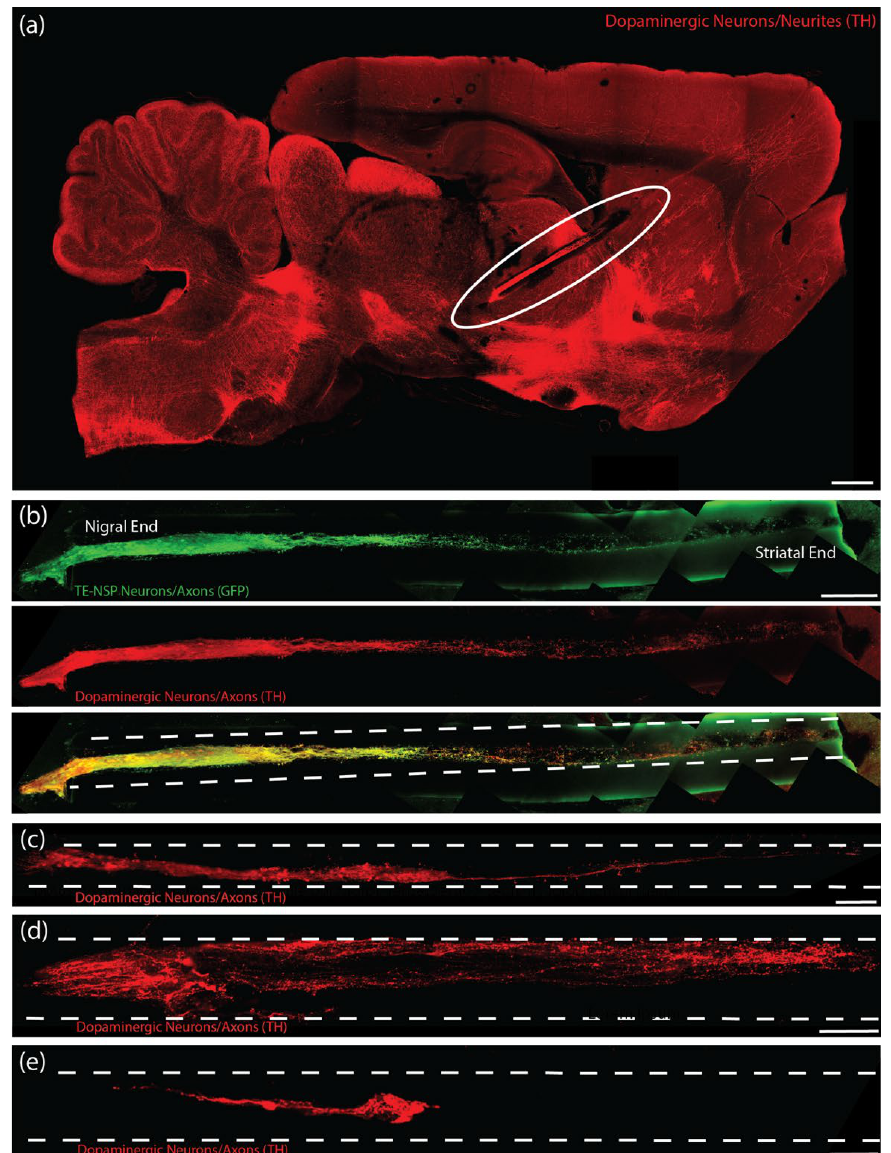
Figure 9. TE-NSP neuronal survival and axon architecture at 1-month post-implant in rat 6-OHDA lesion model of PD. ( a ) Representative confocal reconstruction of an enriched TE-NSP 1-month post- implant labeled via immunocytochemistry to denote dopaminergic neurons/axons (TH, red). The aggregate end of the TE-NSP was positioned in the SN while the axonal end of the TE-NSP ter- minated in the striatum. Implanted neurons and axons tracts were preserved in lesioned animals. Background has been increased to display the intact physical structure of the brain surrounding the implant and along its implantation path. ( b ) Representative confocal reconstruction of an enriched TE-NSP 1-month post-implant labeled via immunohistochemistry to denote GFP (GFP, green) and dopaminergic neurons/axons (TH, red). ( c – e ) Representative confocal reconstructions showing various types of implanted constructs at 1-month post-implant labeled via immunohistochemistry to denote dopaminergic neurons/axons (TH, red). ( c ) Enriched TE-NSPs maintained their cytoarchi- tecture with discrete somata and axonal regions; they also demonstrated neurites spanning the full length of the micro-column. ( d ) Non-enriched TE-NSPs generally did not exhibit neurites spanning the length of the micro-column. ( e ) Enriched aggregates added to micro-columns 1 day prior to implant did not display long-distance neurite outgrowth within the micro-column. Scale bar ( a ) = 1 mm. Scale bar ( b ) = 250 µ m. Scale bar ( c ) = 200 µ m. Scale bar ( d , e ) = 100 µ